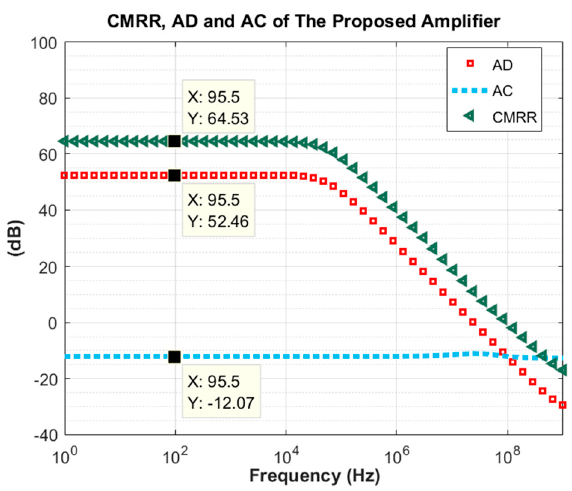
Figure 7. AC, AD, and CMRR vs. frequency analysis of the proposed ampli fi er.